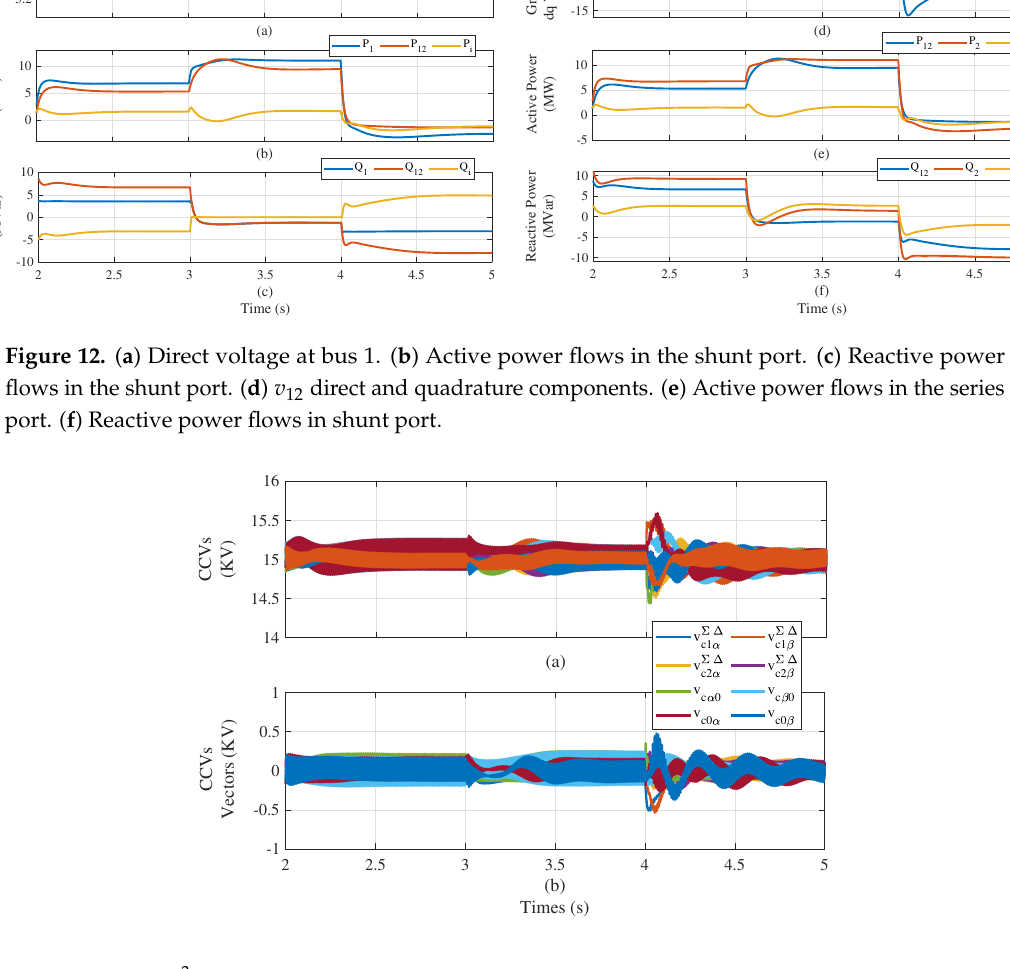
Figure 13. M 3 C operating as UPFC: ( a ) CCVs. ( b ) CCV vectors in the Σ∆ double- αβ 0